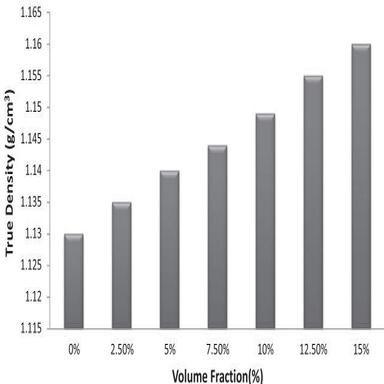
True density of pure epoxy and epoxy + wool.